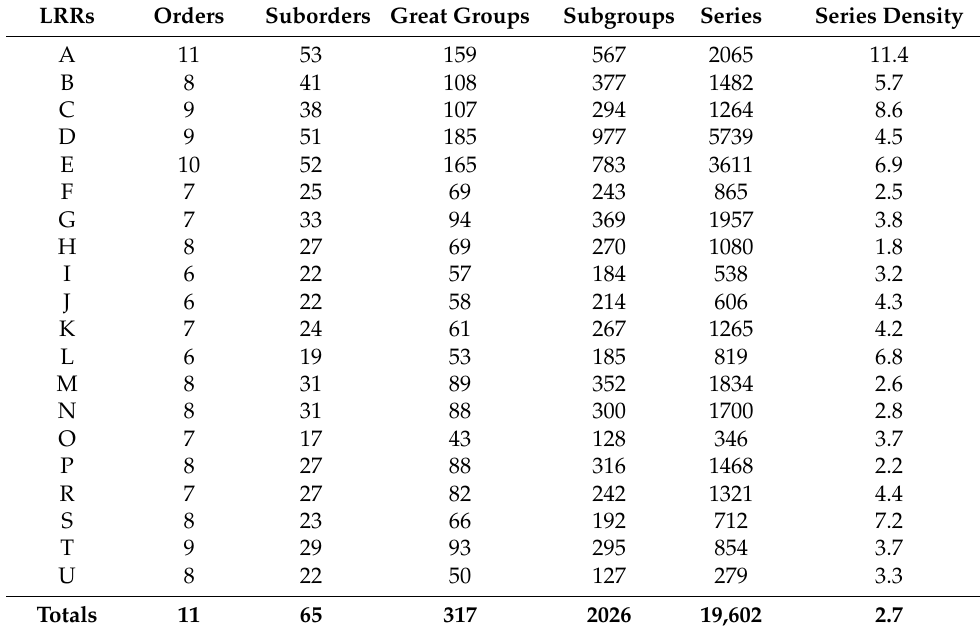
Note: A = Northwestern Forest, Forage and Specialty Crop Region; B = Northwestern Wheat and Range Region; C = California Subtropical Fruit, Truck and Specialty Crop Region; D = Western Range and Irri- gated Region; E = Rocky Mountain Range and Forest Region; F = Northern Great Plains Spring Wheat Region; G = Western Great Plains Range and Irrigated Region; H = Central Great Plains Winter Wheat and Range Region; I = Southwest Plateaus and Plains Range and Cotton Region; J = Southwestern Prairies Cotton and Forage Region; K = Northern Lake States Forest and Forage Region; L = Lake States Fruit, Truck and Dairy Region; M = Central Feed Grains and Livestock Region; N = East and Central Farming and Forest Region; O = Mississippi Delta Cotton and Feed Grains Region; P = South Atlantic and Gulf Slope Cash Crops, Forest and Livestock Region; R = Northeastern Forage and Forest Region; S = Northern Atlantic Slope Diversified Farming Region; T = Atlantic and Gulf Cost Lowland Forest and Crop Region; U = Florida Subtropical Fruit, Truck Crop and Range Region. Series density equals the number of series divided by 100,000